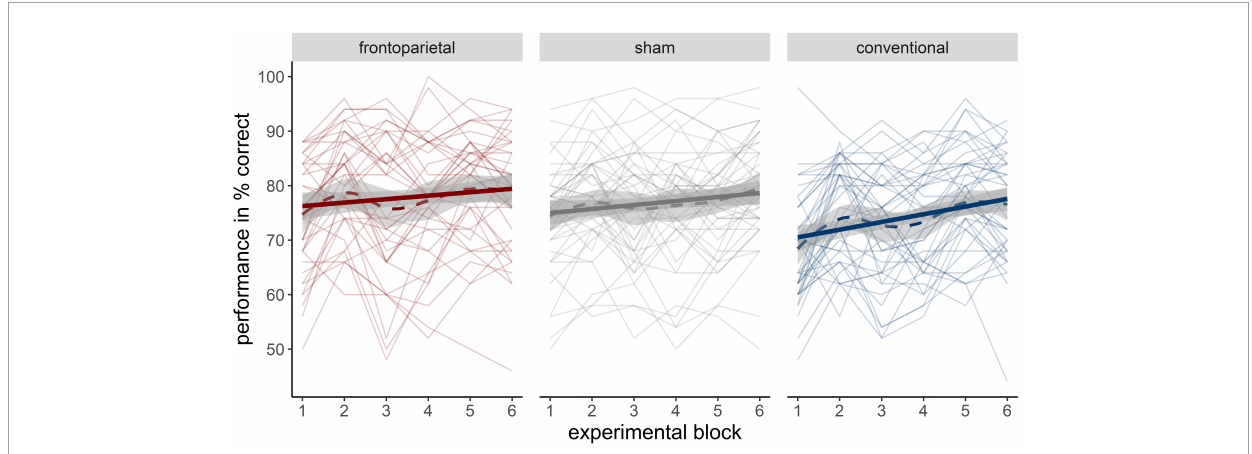
FIGURE3 Performance increase across different stimulation groups ( left : frontoparietal; middle : sham; right : conventional). Bold solid trajectories depict the group mean within a 95% CI. Thin solid lines resemble individual performance trajectories of participants. Bold dashed lines show the loess smoothed group